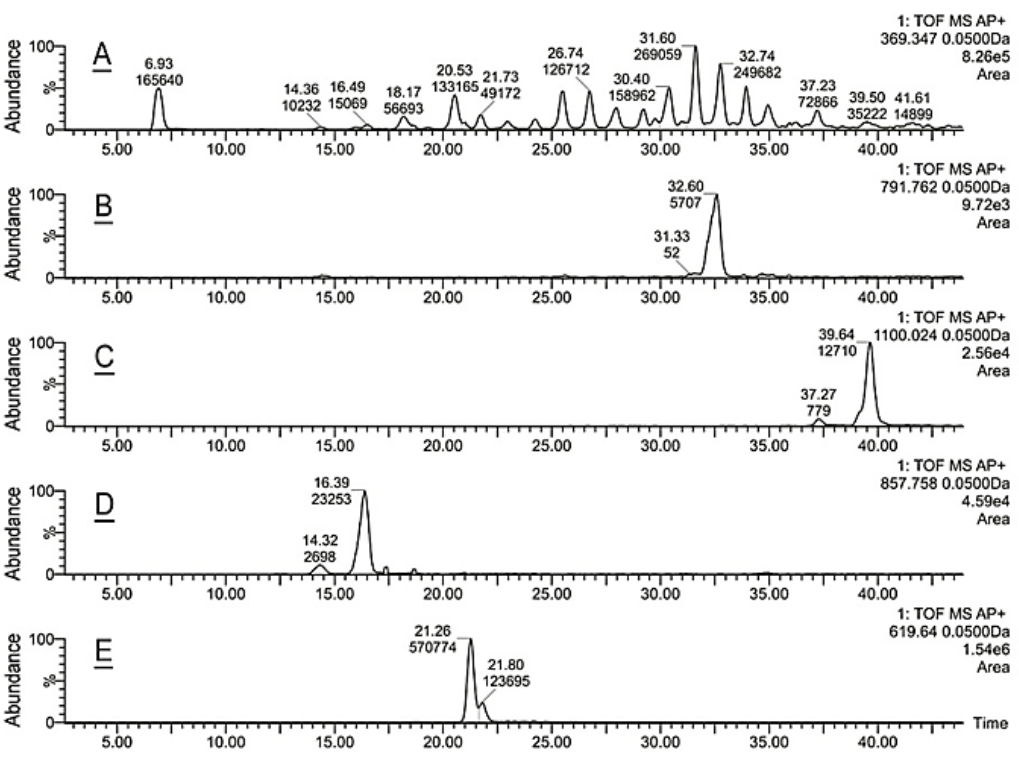
Figure 2. Lipidomic reverse phase chromatography/high-resolution mass spectrometry in atmospheric pressure chemical ionization mode (RP UPLC/APCI MS) analysis of normal mouse meibum in positive ion mode. ( A ) Extracted ion chromatogram of free Chl (a peak with a retention time 6.93 min) and CE (peaks with retention times between ~14 min and ~40 min) detected as a common analytical ion C 24 H 45+ . ( B ) Extracted ion chromatogram of C 28:1 -CE detected as (M + H) + adduct C 55 H 99 O 2+ . ( C ) Extracted ion chromatogram of a Chl-OAHFA detected as (M + H) + adduct C 75 H 135 O 4+ . ( D ) Extracted ion chromatogram of a proton adduct of a TAG detected as (M + H) + adduct C 55 H 101 O 6+ . ( E ) Extracted ion chromatogram of a wax ester detected as (M + H) + adduct C 42 H 83 O 2+ . Integrated peak areas (ion counts) are shown in the graphs below the retention times (in minutes). Normalized chromatograms are shown.